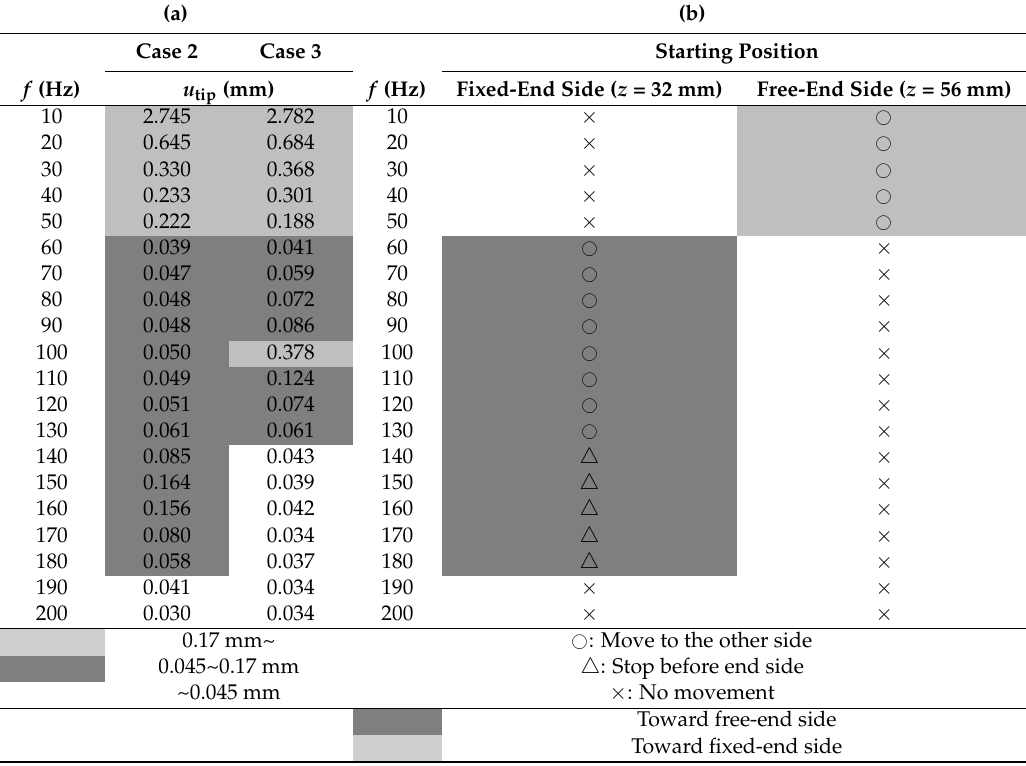
Table 4. Relationship between ( a ) Tip displacement and ( b ) Movement of the proof mass corresponding to input frequency (Type 1).